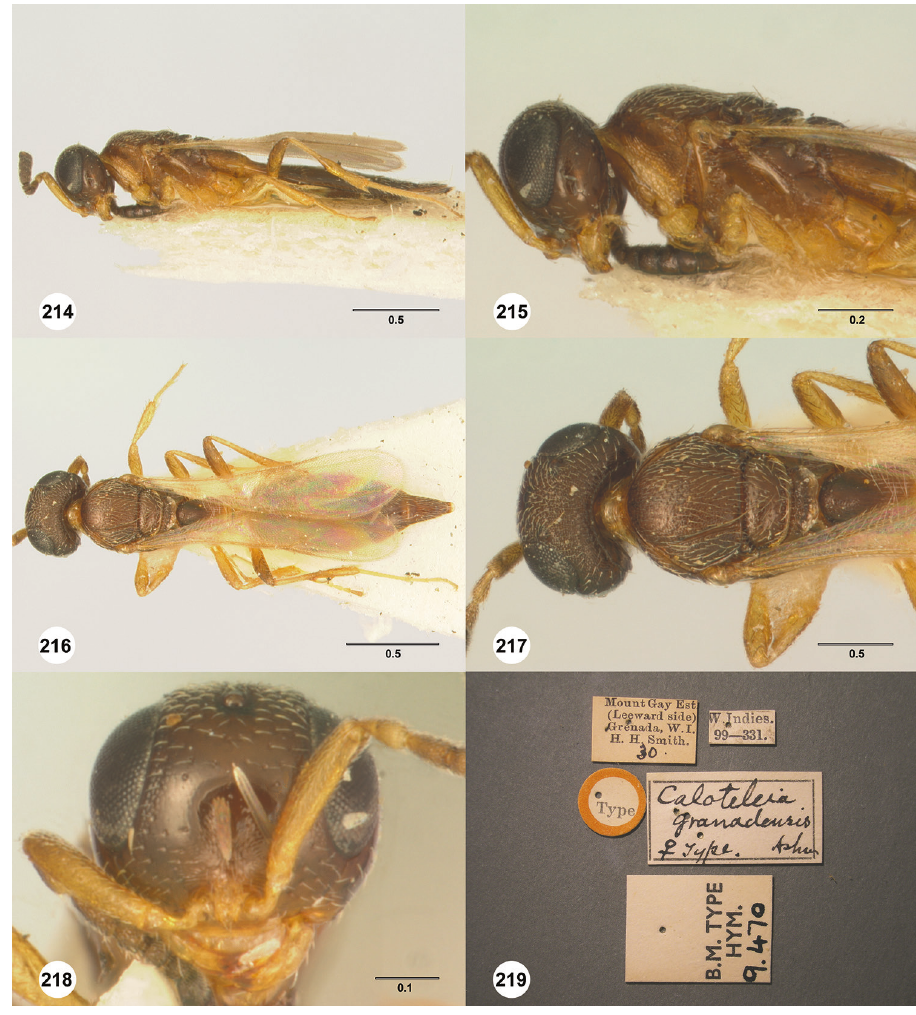
214 Lateral habitus 215 Head and mesosoma, lateral view 216 Dorsal habitus 217 Head and mesosoma, dorsal view 218 Head, anterior view 219 Specimen labels. Scale bars in